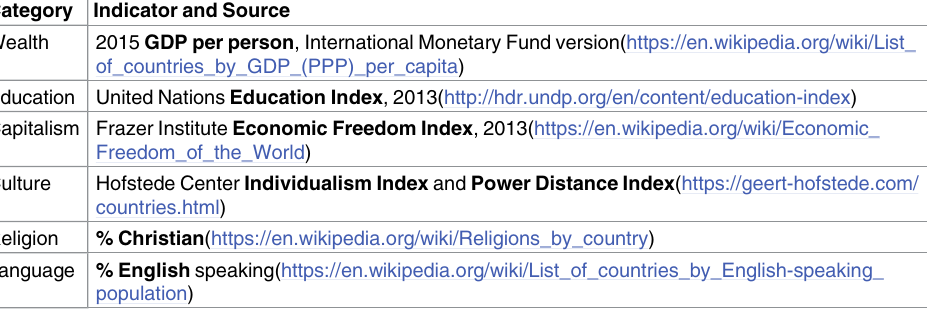
Table 3. National indicators and